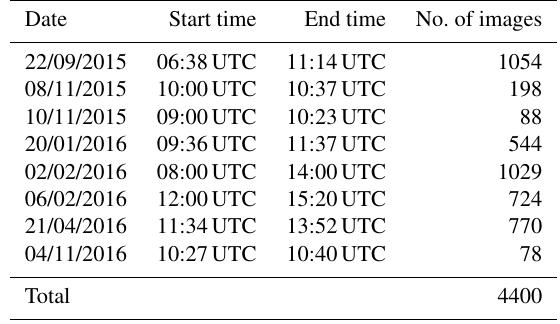
Table 1. HaloCam RAW 22 ◦ halo days between 22 September